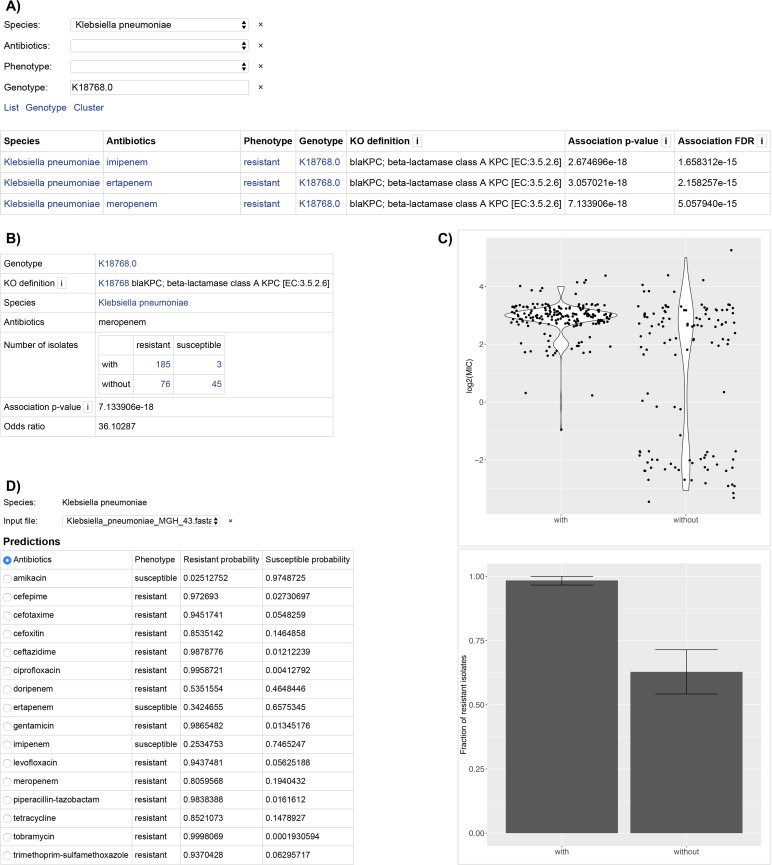
VAMPr provides rich sets of online resources for association models and prediction models.Users have the flexibility to explore known or novel antibiotic resistance-associated variants, and can upload their own sequence assembly and obtain predictions on antibiotic resistance. (A) association results webpage: users can explore variants, their interpretations, and their statistical significance assessments; (B) detailed information, contingency table and odd-ratio for variant K18768 in the association model, and distribution plots; (C) Distribution plots for variant K18768 in the association model page; (D) prediction models allow for uploads of users’ sequence data for antibiotic resistance prediction.